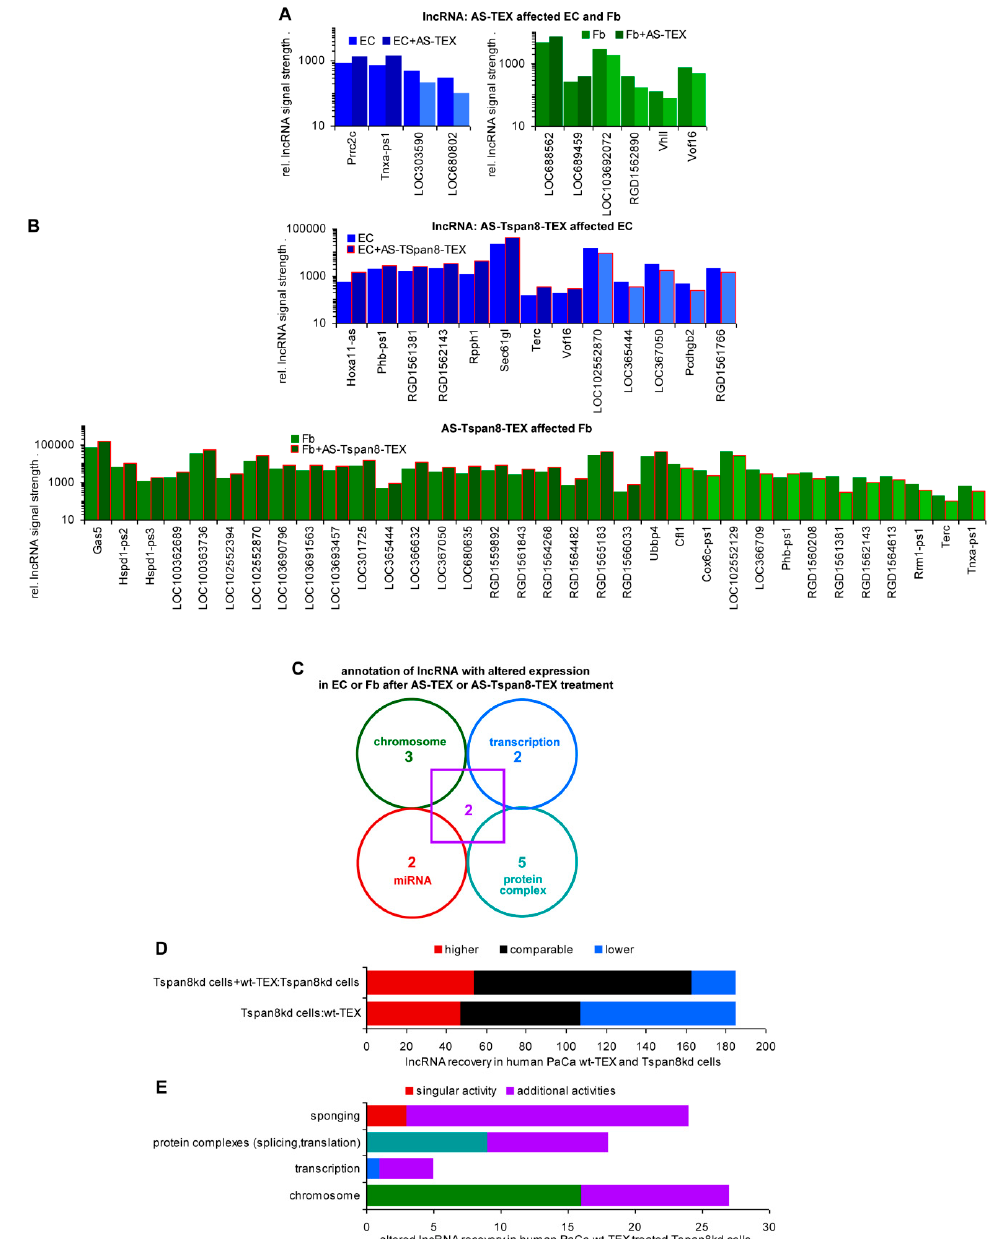
Figure 7. Impact of TEX-promoted long noncoding RNA (lncRNA) up- or downregulation on fibroblasts and endothelial cells. Di ff erent lncRNA recovery in EC and Fb after coculture with ( A ) AS-TEX or ( B ) AS-Tspan8-TEX. ( C ) Functional assignment of 14/52 lncRNA that expression was altered in EC or Fb after cocultures with TEX. (D) Comparison of lncRNA recovery in human pancreatic adenocarcinoma (PaCa) Tspan8kd cells to wild type (wt)-TEX and of wt-TEX-treated Tspan8kd cells to Tspan8kd cells. (E) Functional assignment of human lncRNA displaying altered expression in wt-TEX-treated Tspan8kd cells. Full name of gene symbols: Tables S8, S9G. According to the current state of information, lncRNA is preferentially engaged in chromosome modulation and complex formation with proteins frequently affecting splicing and translation. With